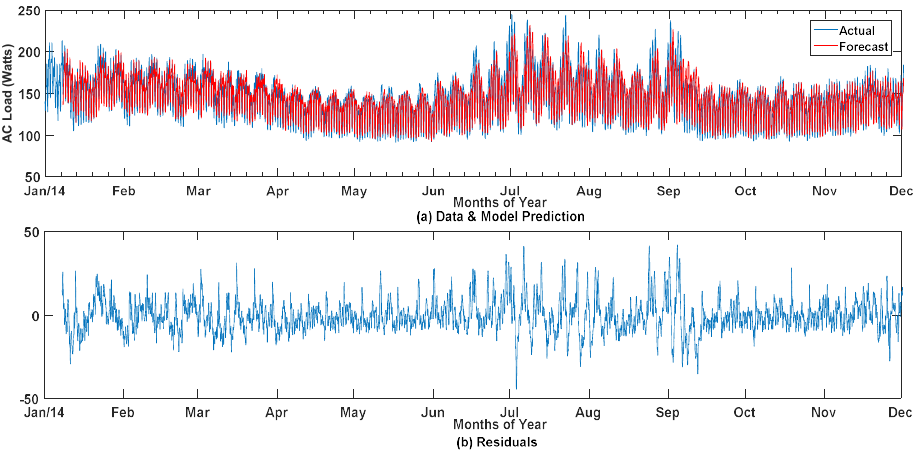
Figure 5. Actual and forecasted AC loads by multiple linear regression approach.